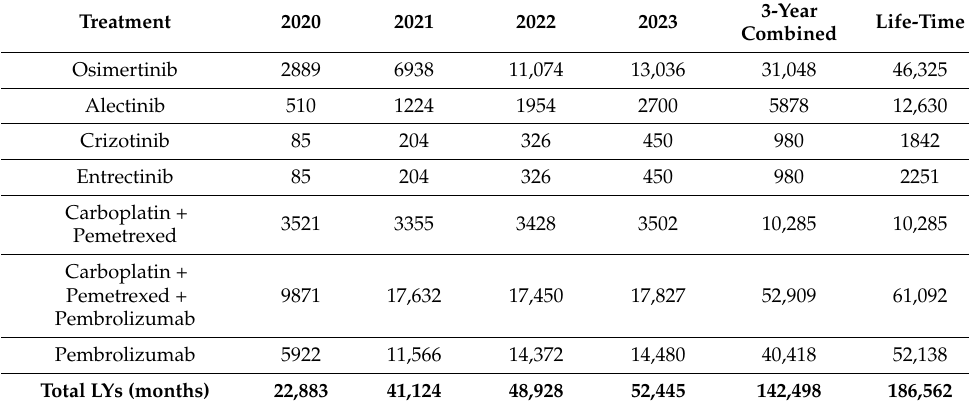
Table 8. Population LYs gained—new scenario.